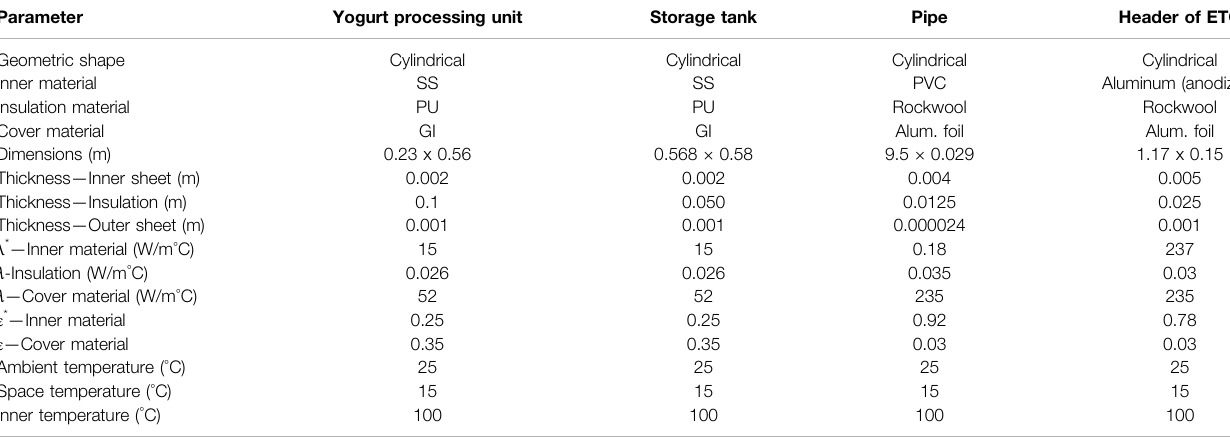
TABLE 1 | Metadata for the current prototype of the solar assisted yogurt processing unit.